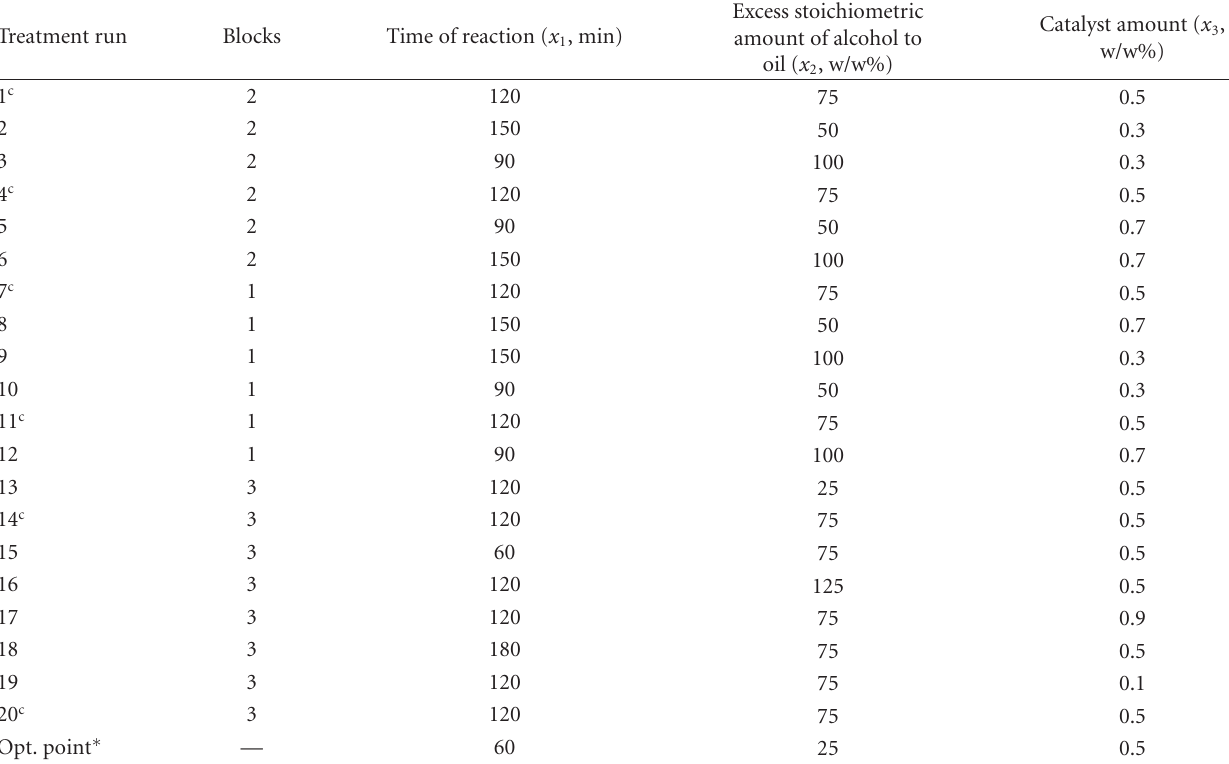
Table 1: The matrix of central composite design (CCD) resulted from response surface methodology design of experiment. Treatment